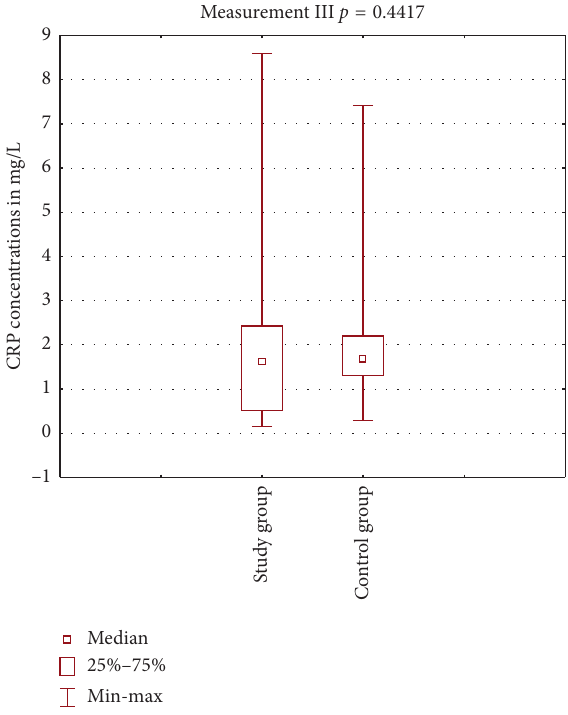
Figure 5: Analysis of the results of measurements in both groups—measurement